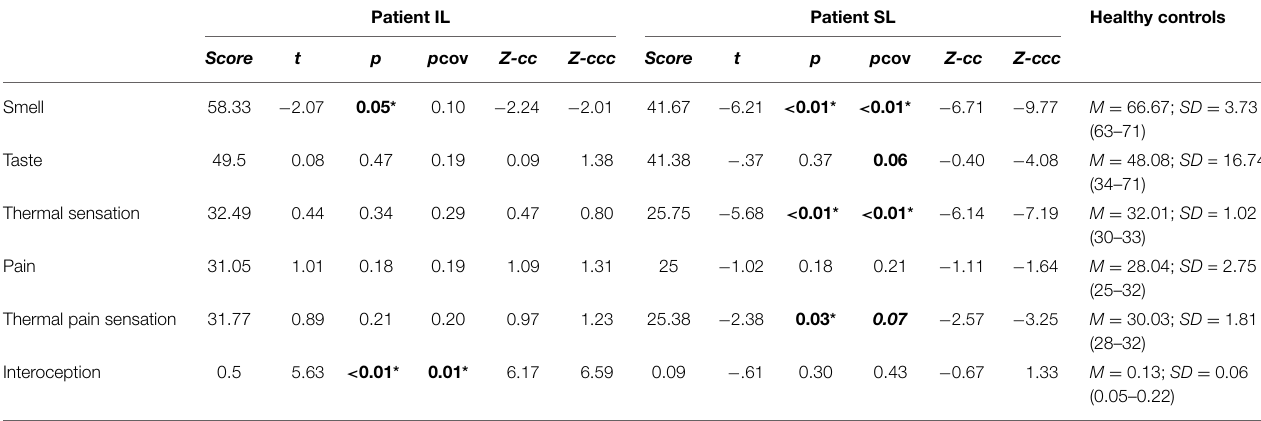
TABLE 4 | Results of comparing patient IL and SL with healthy age-matched controls. Patient IL Patient SL Healthy controls